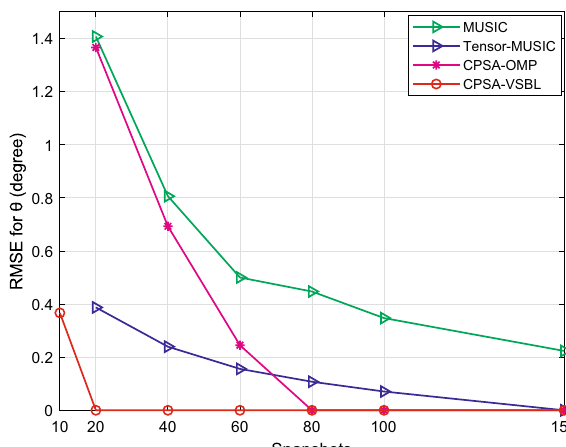
Fig. 6 The azimuth RMSE versus number of